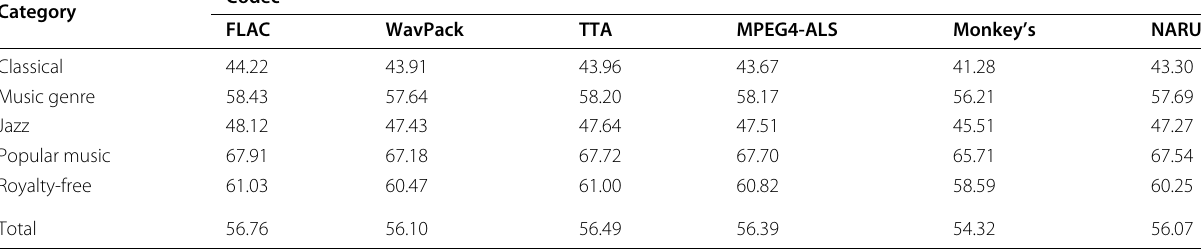
Table 2 Compression ratio (Eq. (36)) comparison